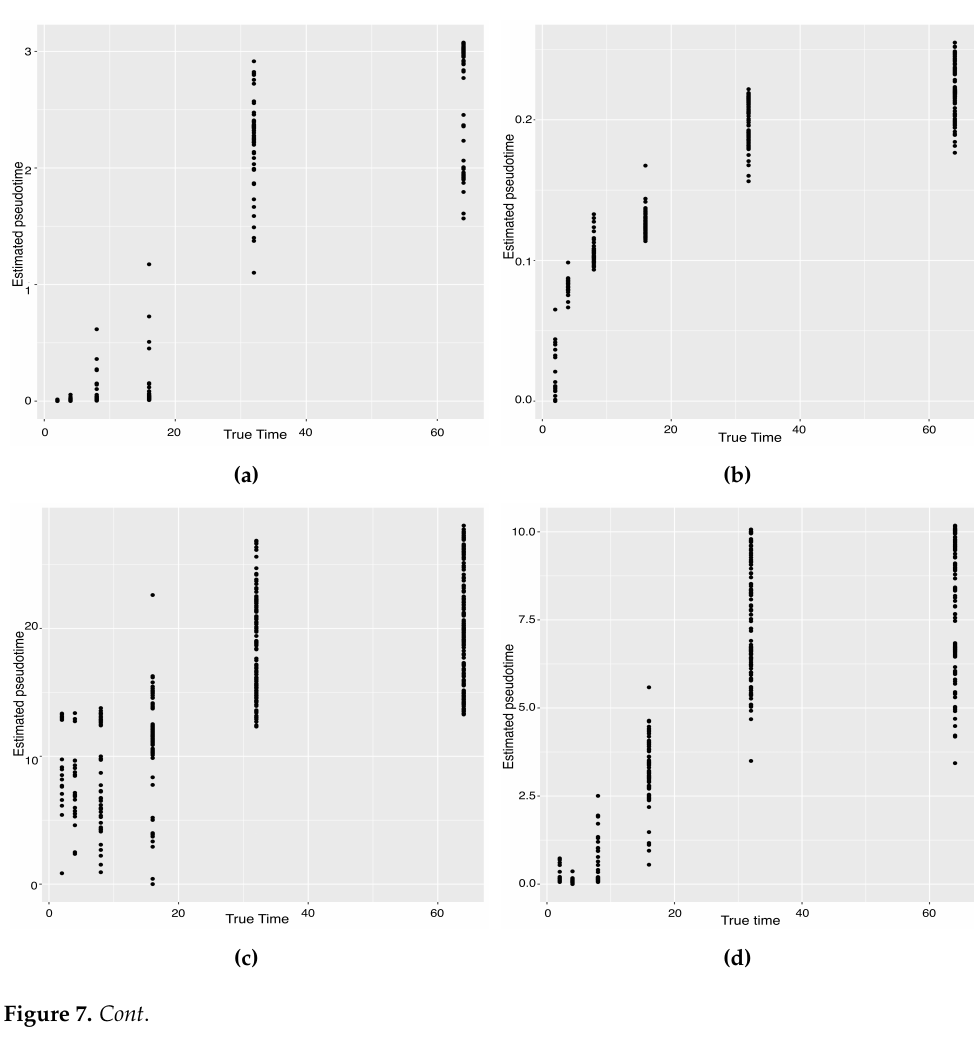
Figure 6. Cell trajectories estimated by our linear STS and curved tree methods on the Zygote– Blastocyst dataset. ( a ) Linear tree method. ( b ) Curved tree method.